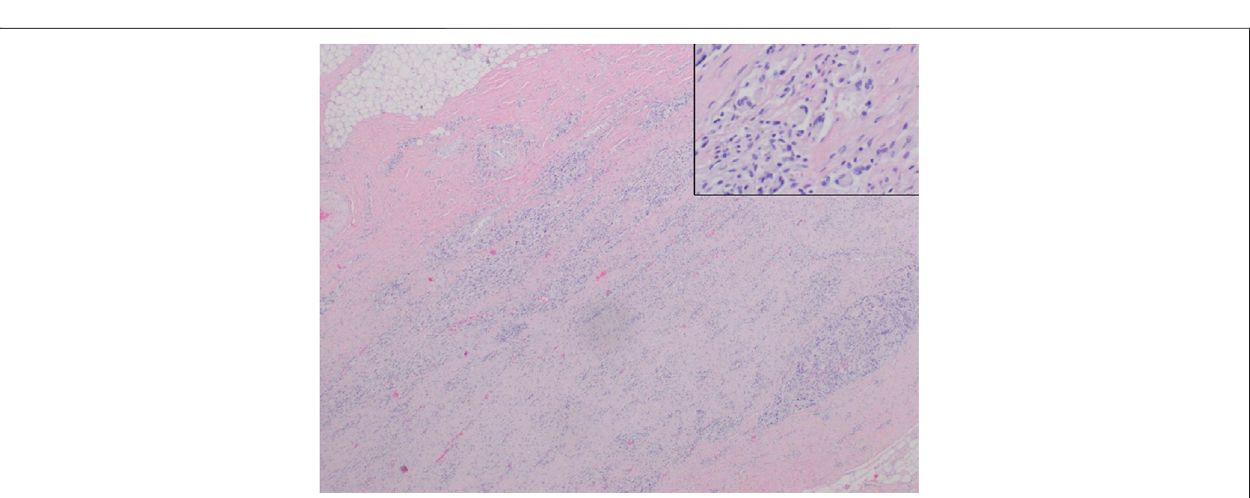
FIGURE 4 | Auricle. Interstitial granules (insert) are visible between the thick bundles of fi brous scar tissue.